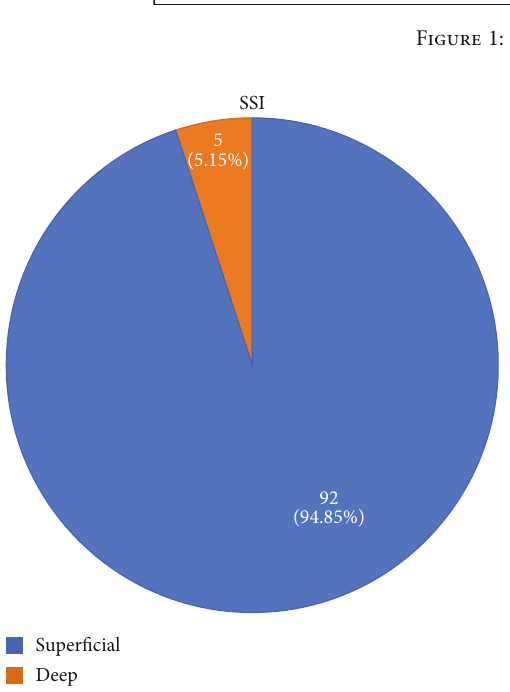
Figure 2: Types of SSI in the